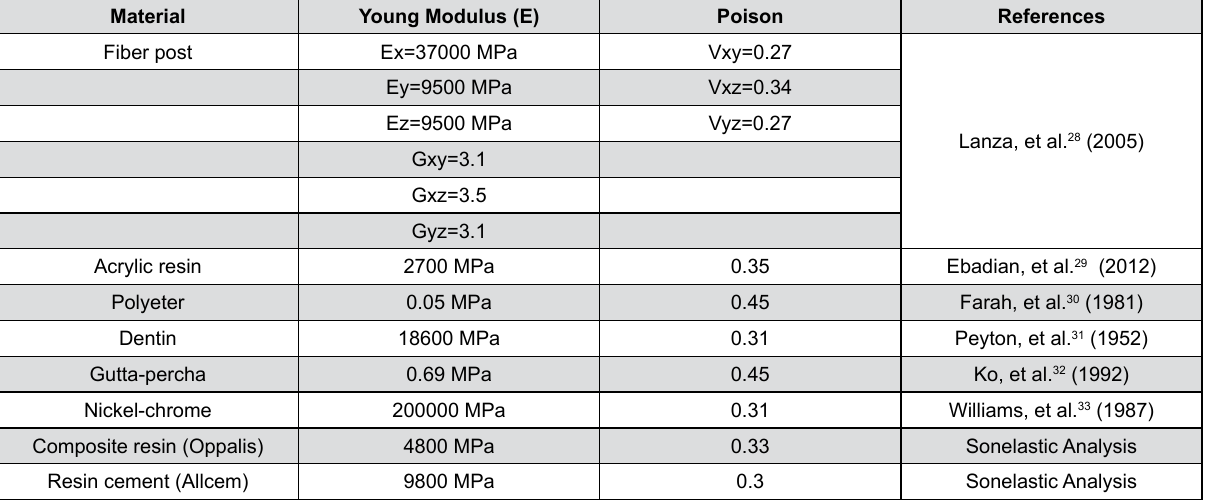
Figure 3- Materials, properties and references used for the finite element analysis